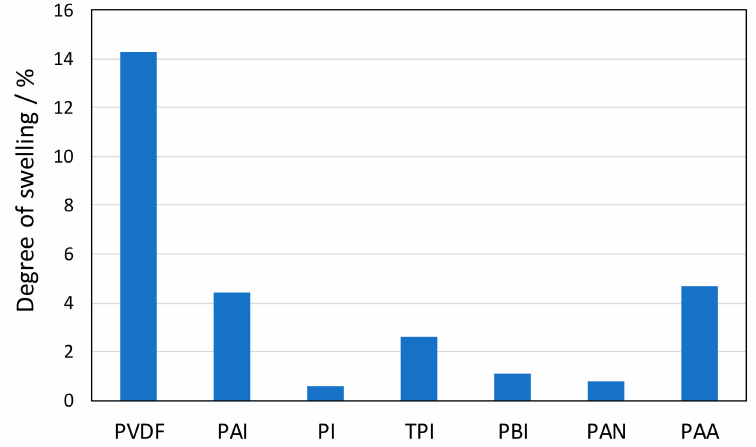
Figure 6. Comparison with degree of swelling.